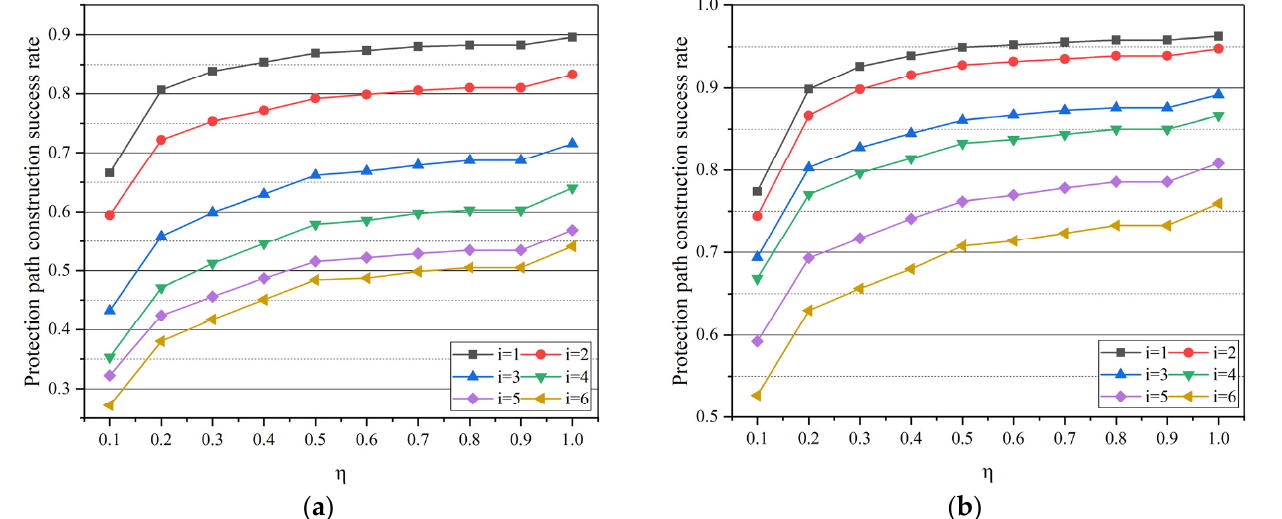
Figure 9. Simulation results: ( a ) protection path construction success rate varies with η in the case of different untrusted node numbers in NSFNET; ( b ) protection path construction success rate varies with η in the case of different untrusted node numbers in USNET.